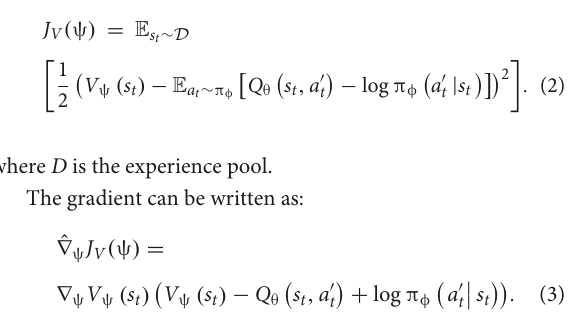
Figure 1 . The parameter of Actor-network is φ . The probability distribution π φ ( · | s t ) of the strategy is obtained according to the input state s t , and then the action a t is output according to the probability. The action a t will be acted on the environment to obtain s t + 1 and r t + 1 . The experience data ( s t , a t , r t + 1 , s t + 1 ) is stored in the experience pool. The input of the Critic- network is state s t , where the parameter of V network is ψ , and the estimated value of output state V ψ ( s ) ; The parameter of Q-network is θ , and the output is state-action value estimation Q θ ( s t , a t )